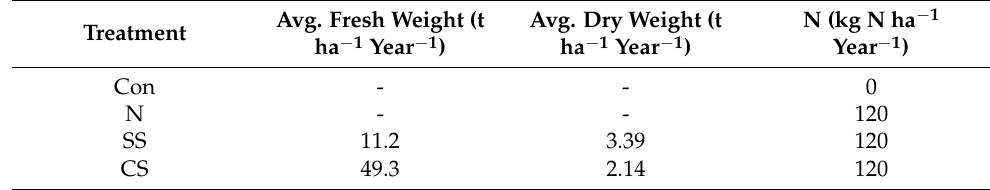
Table 2. Experimental design, applied organic and nitrogen fertilizers.